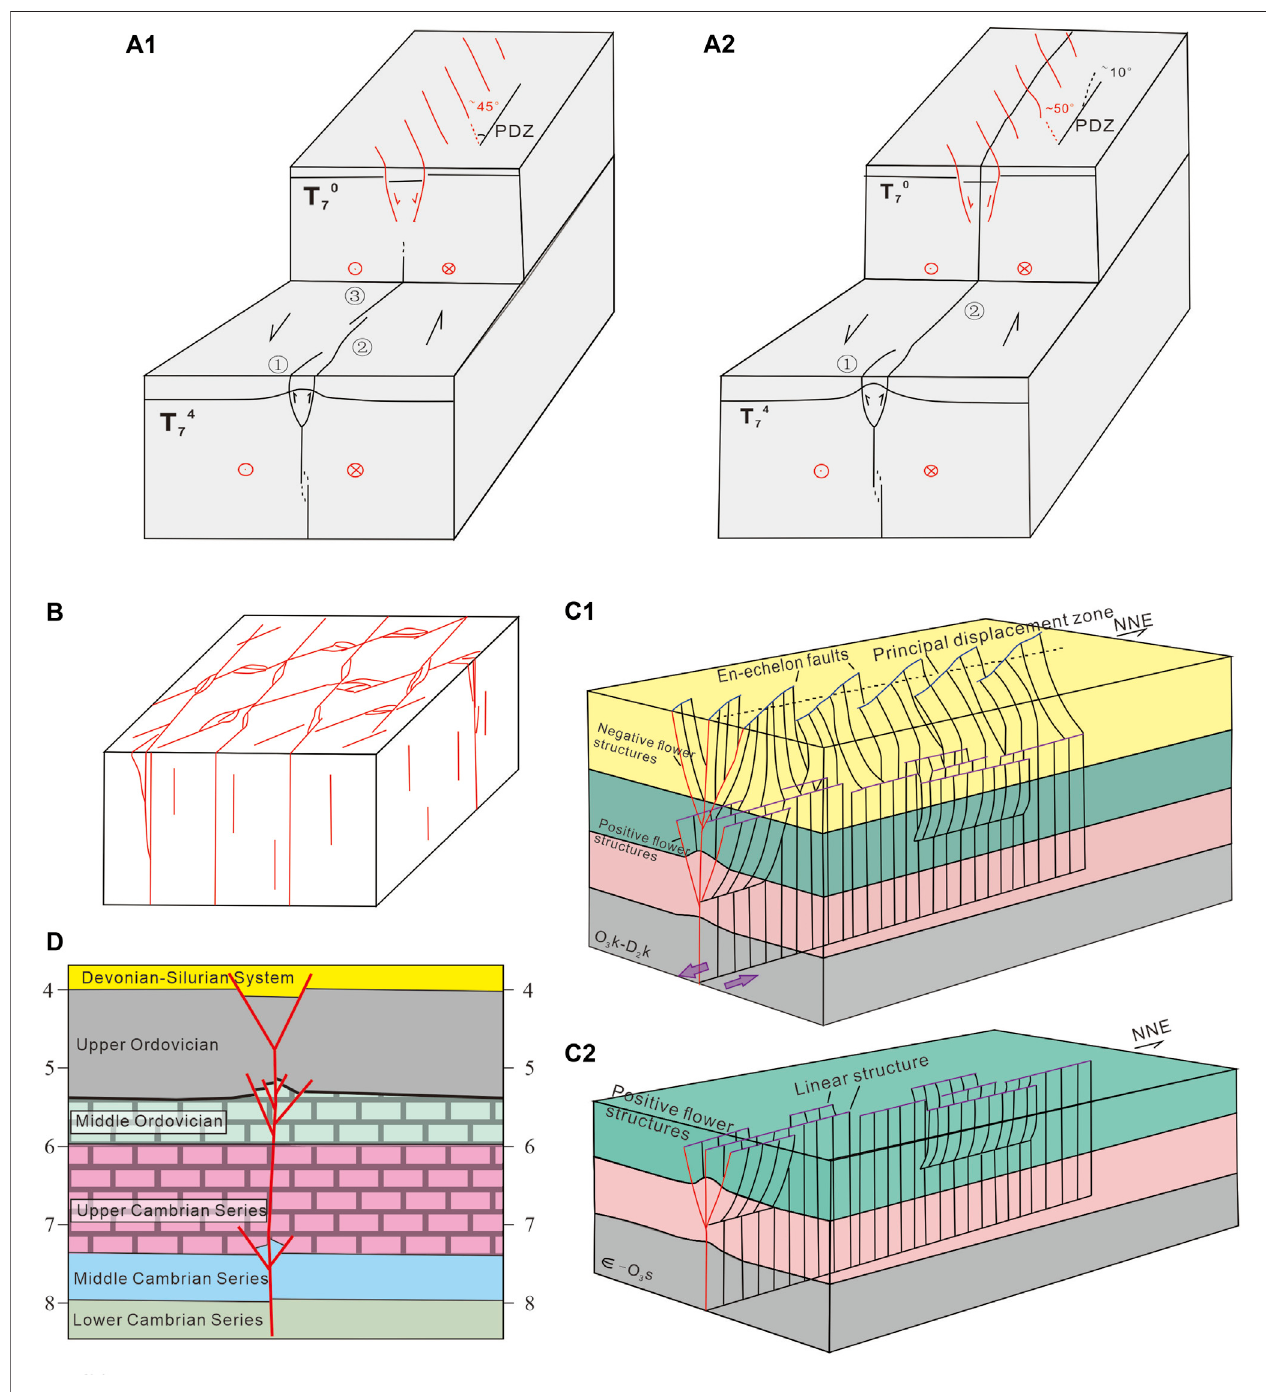
FIGURE 3 | Models of strike-slip faults in the central Tarim Basin of the previous research (modi fi ed from Han et al., 2017; Wu et al., 2020a; Deng et al., 2019): (A1 – A2) models of the evolution history of strike-slip faults from the Manxi low uplift (modi fi ed from Deng et al., 2019), (B) model of strike-slip faults from the Tabei uplift (modi fi ed from Wu et al., 2020b), (C1 – C2) models of the stages of evolution of strike-slip faults from the northern slope of the Tazhong uplift (modi fi ed from Han et al., 2017), and (D) model of strike-slip fault from the Tazhong uplift (modi fi ed from Neng et al., 2018).